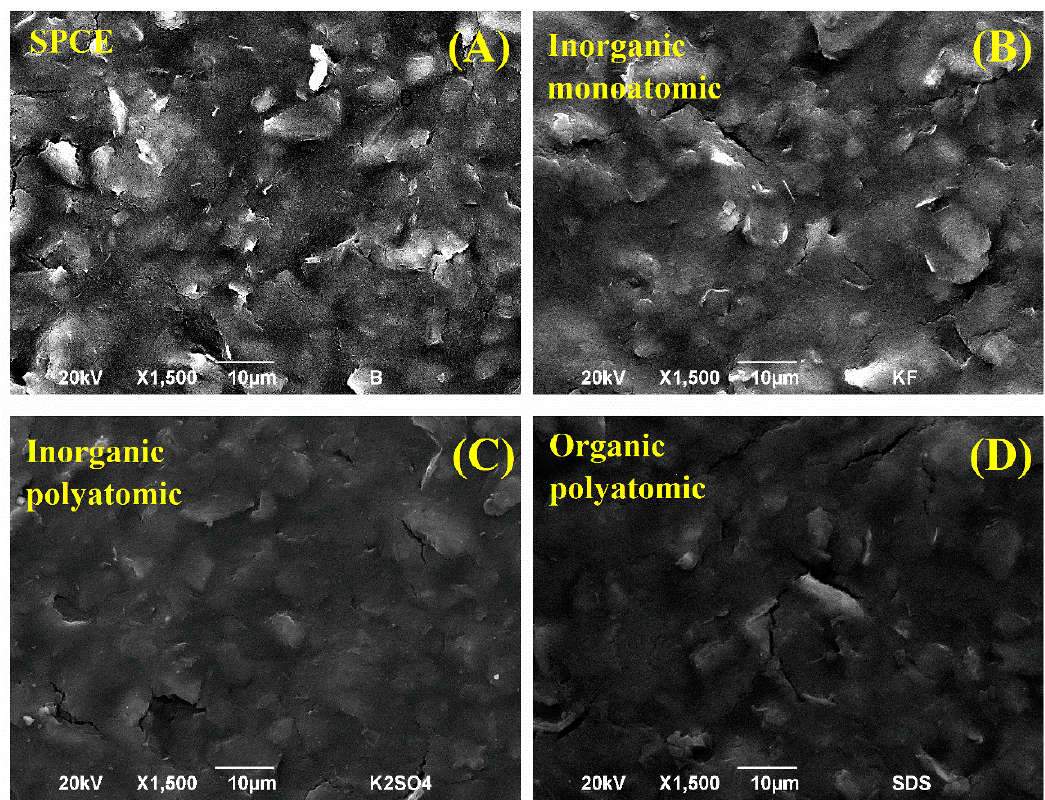
Figure 3. SEM images of ( A ) a bare SPCE and some modified SPCEs by: ( B ) PAA(F), ( C ) PAA(SO 4 ) and ( D ) PAA(DS) films. All the images were recorded at 1500 × magnification and markers correspond to 10 µm.